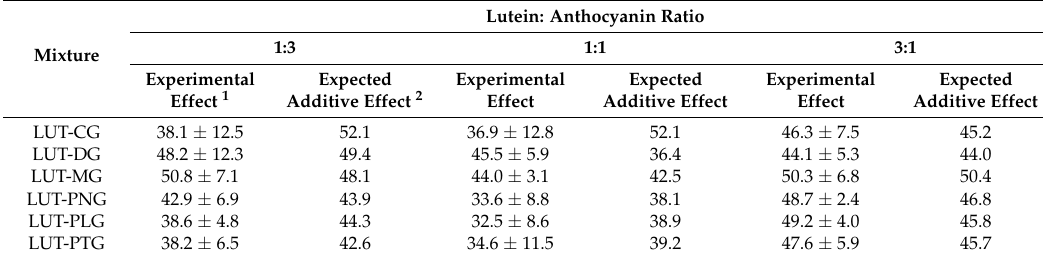
Table 1. Cellular antioxidant activity (CAA) of lutein-anthocyanin